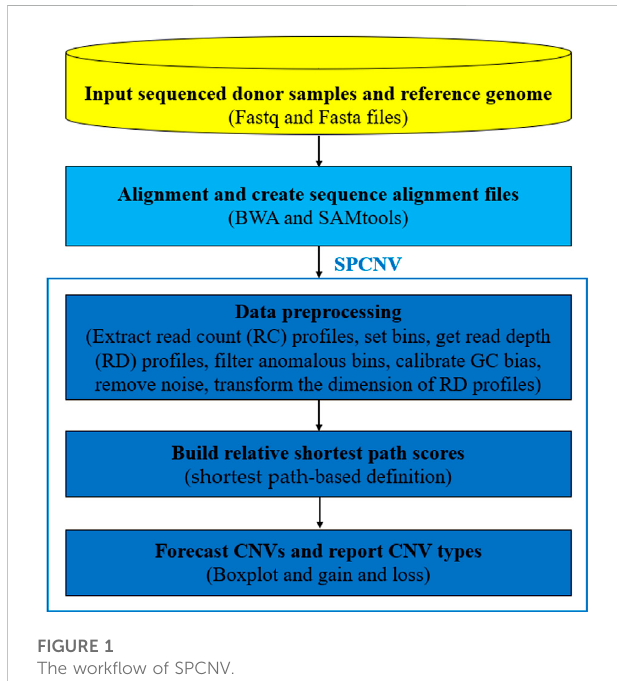
FIGURE 1 The work fl ow of